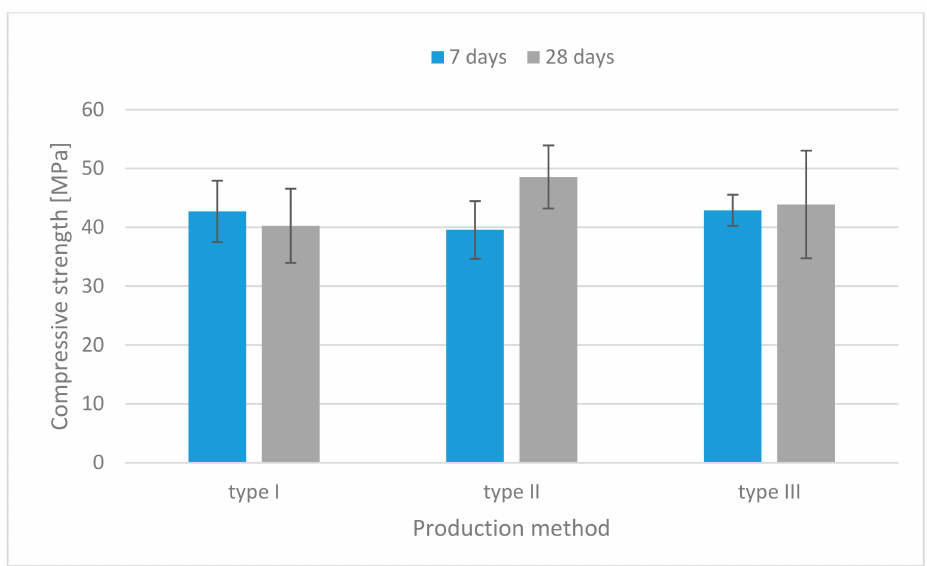
Figure 4. Compressive strength histograms (specimens containing flax fibers).